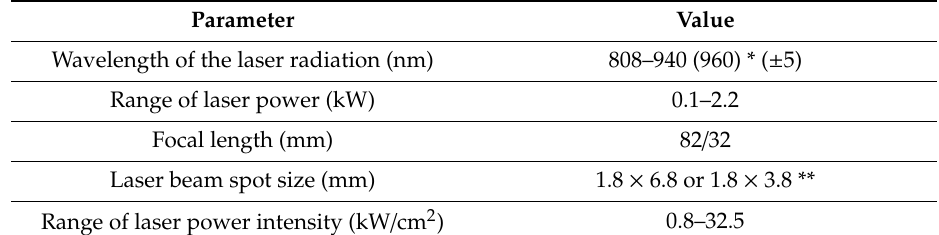
Table 1. Technical data of the continuous wave (CW) high power direct diode laser ROFIN DL 020 (Figure 1).